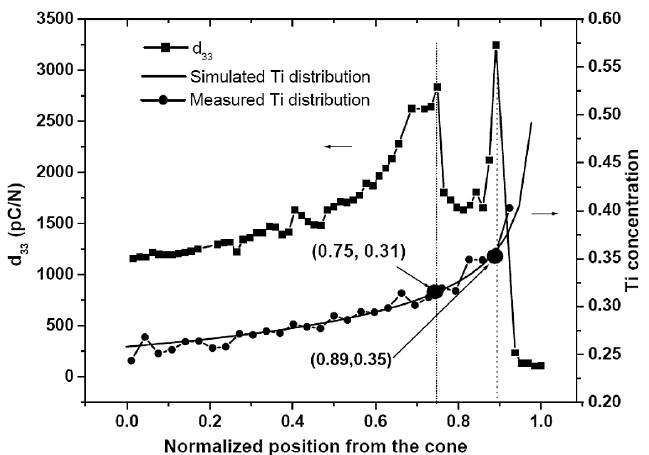
Figure 3. Comparison of piezoelectric property ( d distribution. Reprinted with permission from [28]. Copyright 2008 CRC